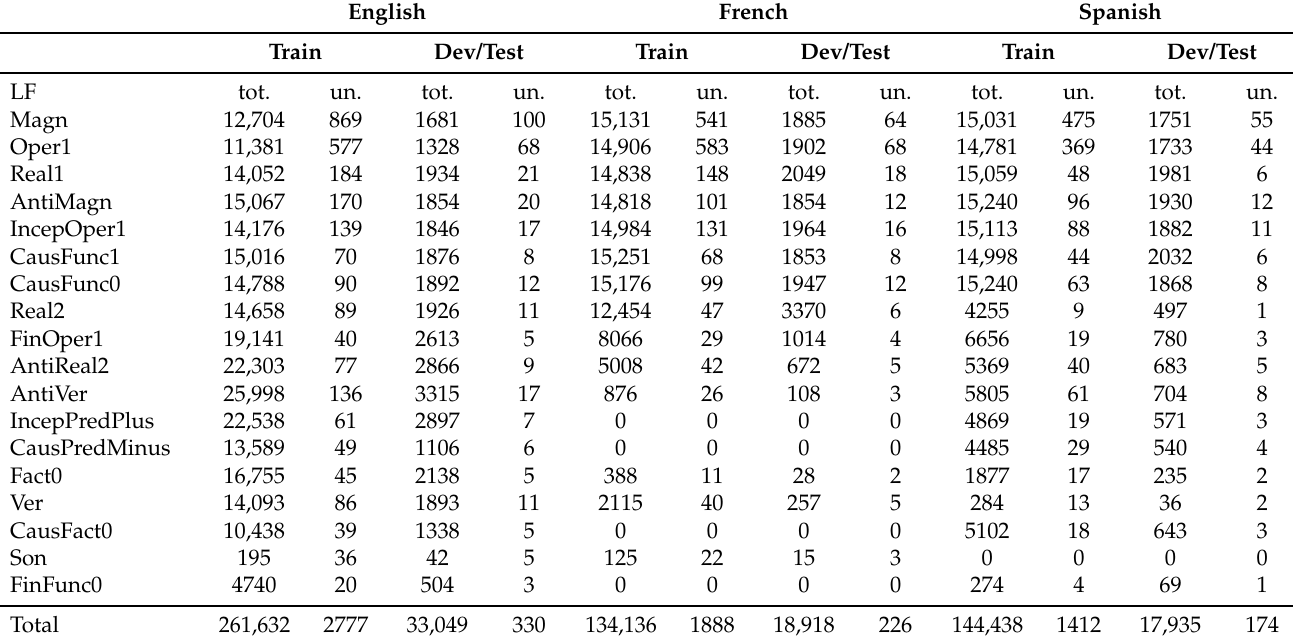
Table 2. Number of collocations, in total (tot.) and unique (un.), in the datasets across the